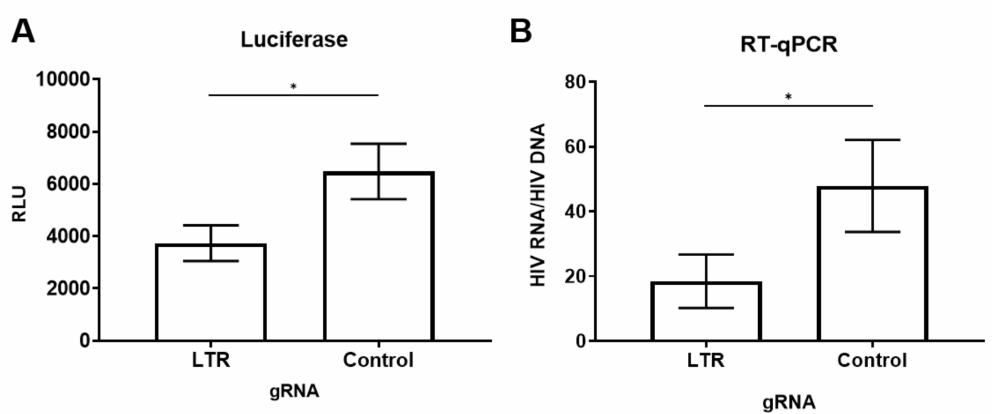
Figure 2. Repression of Proviral HIV transcription. HEK293T cells were infected with NL4-3-env-luciferase (MOI of 0.1) for 24 h and cotransfected with dCas9-KRAB and LTR targeting guide (397) or a scrambled control. Forty-eight hours post transfection, cells were monitored for HIV-1 expression by measuring ( A ) luciferase ( n = 16 independent experiments) and ( B ) HIV-1 RNA ( n = 5 independent experiments). Bars represent the mean of these results and error bars are the standard error. Student t -test was performed. * indicates p ≤